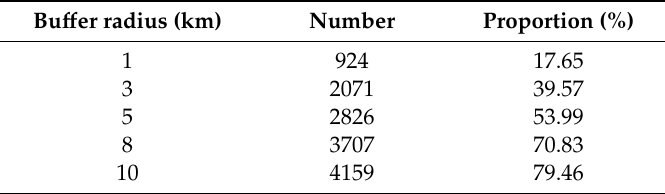
Table 3. Proportions of toponyms in the water-related toponym dataset (WRTD) in di ff erent bu ff ers. Bu ff er radius (km) Number Proportion (%)